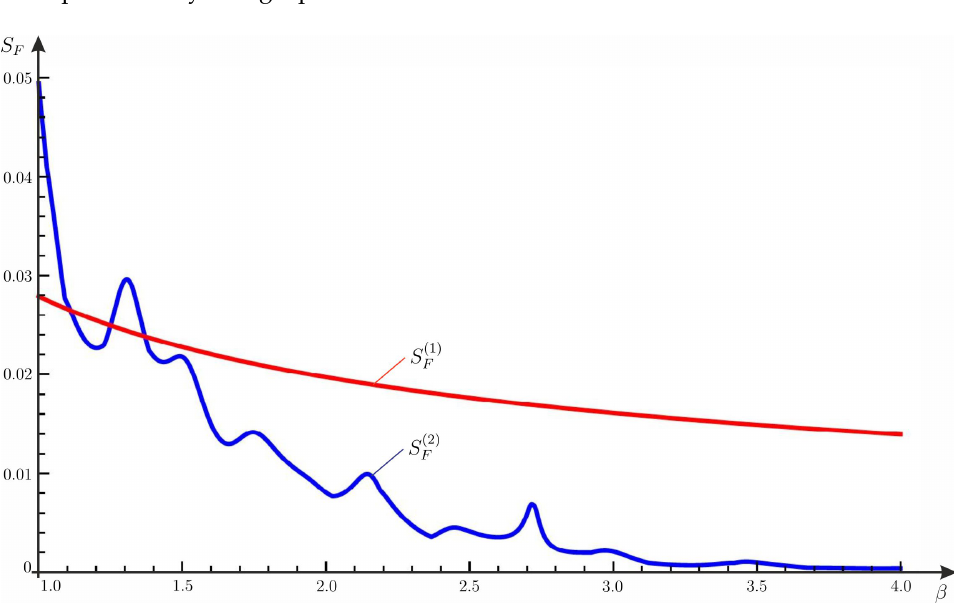
Figure 4. Comparison of the reaction forces produced by a single mass scatterer and by a circular cluster of 12 point mass scatterers of the same combined mass. The incident field is produced by a point source. The data, referred to SI units, used in the computation are h = 0.005, ρ = 2700, D = 818.277, R = 0.05. The graph compares S ( 1 ) S ( 2 ) F for a point scatterer of mass 600 (red) with F for a cluster of 12 points, each of mass 50, on the ring of radius R (blue). The point scatterer appears to scatter more strongly at higher frequencies, as illustrated by the